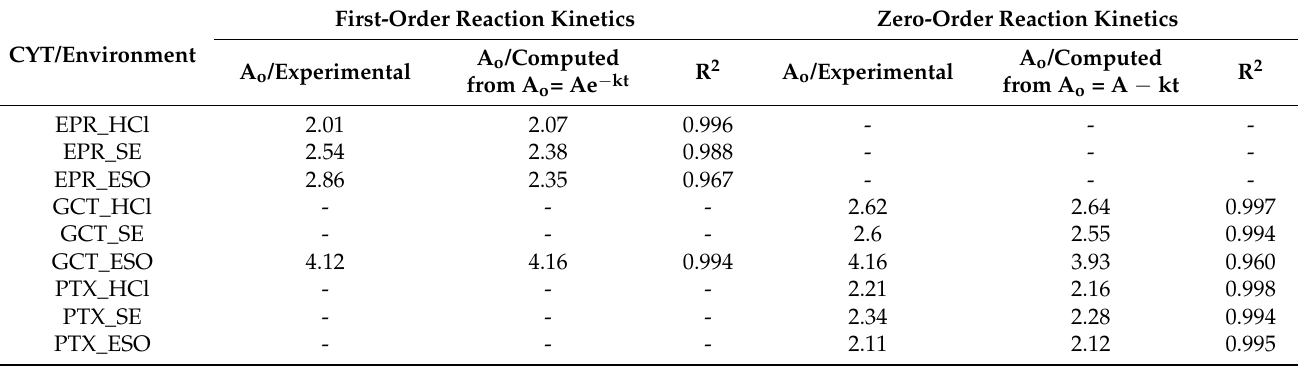
Table 2. The experimental and computed absorbance values from applied kinetic models according to the displayed coefficient R